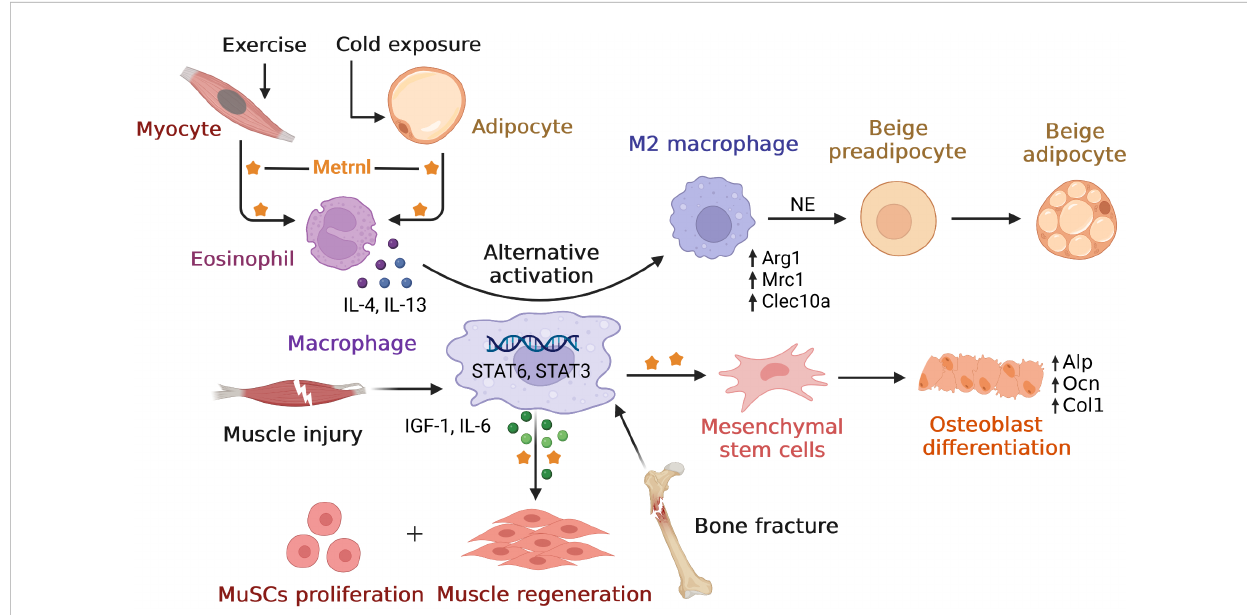
FIGURE 1 Overview of relationships between Metrnl and macrophages. Metrnl could induce IL-4 and IL-13 secretions by eosinophil upon exercise in myocytes and cold exposure in adipocytes. These cytokines stimulated macrophages ’ alternative activation to M2 type via STAT6 signaling, which released norepinephrine (NE) and promoted adipocyte browning to increase thermogenesis. After muscle injury, macrophage-derived Metrnl activated STAT3 signal to induce IGF-1 and IL-6 secretions, thus promoting muscle stem cells (MuSCs) proliferation and skeletal muscle regeneration. Metrnl was highly expressed at regions of osteoblast active and bone depositions during bone fracture healing. Besides, Metrnl could promote mesenchymal stem cells differentiating into osteoblasts with increasing osteogenic